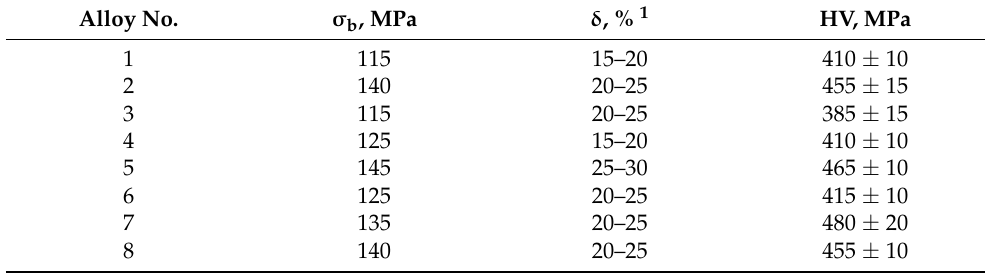
Table 2. Mechanical properties of UFG alloys at room temperature. Alloy